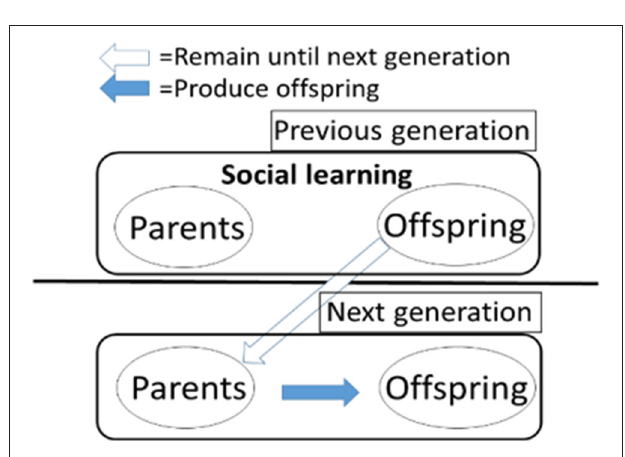
FIGURE 2 | The overlap between generations in the